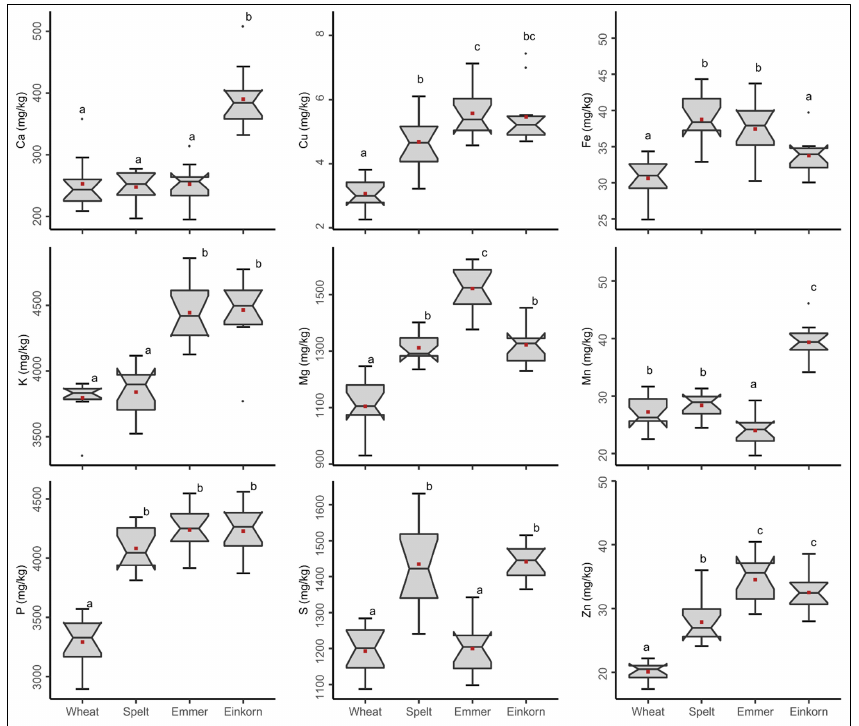
Figure 1. Mineral content in whole grain flours of 12 different varieties in each of the species common wheat, spelt, emmer and einkorn. Boxes with different letters indicate significant differences between the wheat species (ANOVA with Tukey’s test, p < 0.05). Each box summarizes the content of 36 samples (12 varieties grown at three locations in trial series 1). Mean values for each species are highlighted in red color.